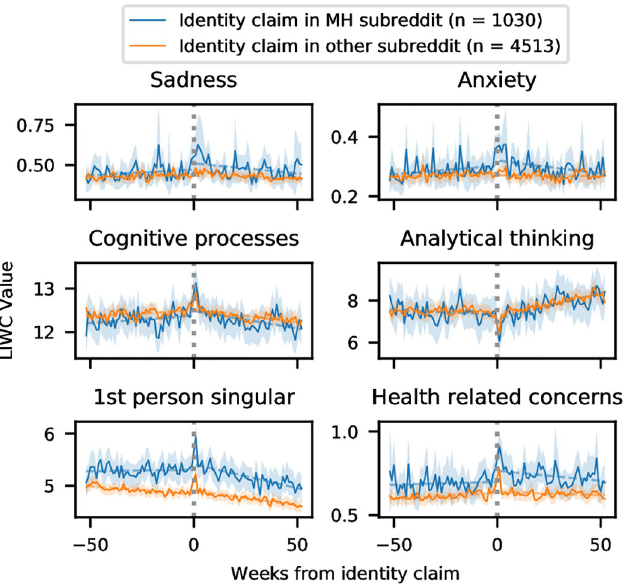
Fig 3. LIWC changes over time for users with whose identity claim takes place in a mental health subreddit, compared with those whose identity claim takes place in a subreddit with a different topic. Analytical thinking is computed based on other categories; the other y axes are percentage of total words. The solid line marks the weekly mean values; the dashed line shows the trend lines for the before and after periods, and the shaded area covers the 95% confidence